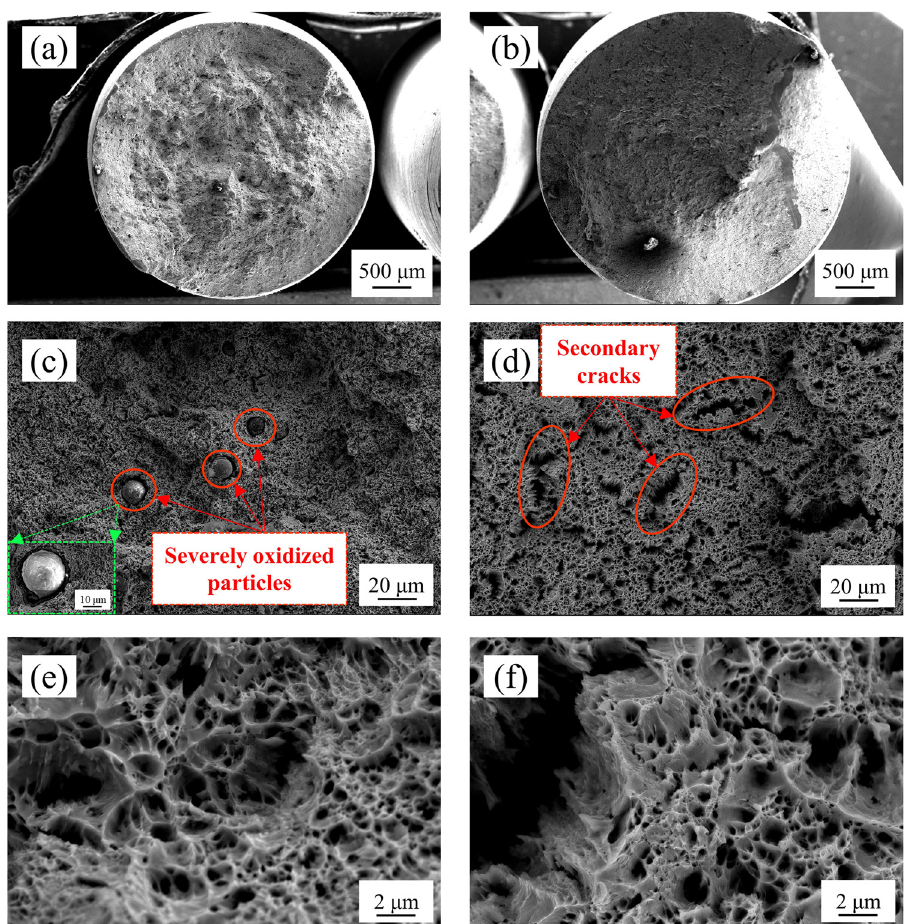
Figure 9: Fracture morphologies of non - milled sample ( a, c and e ) and milled sample ( b, d and f ) after